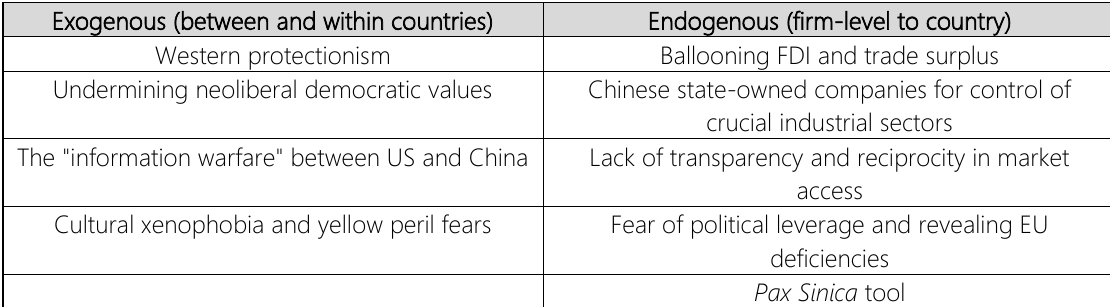
Table 1: Exogenous and endogenous parameters which challenge and undermine COFDI soft power (Source: Author‘s own